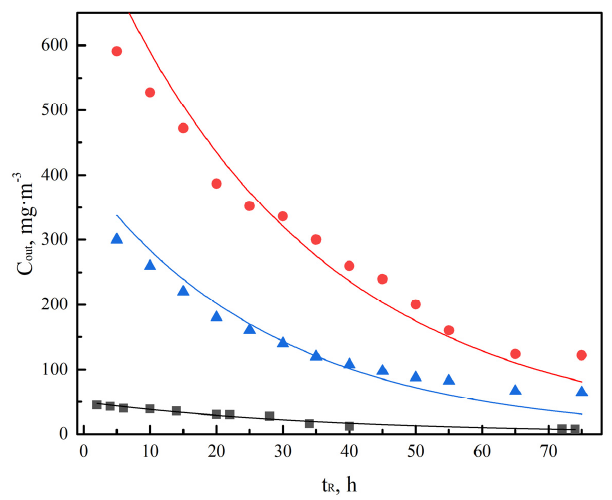
Figure 9. The relationship between outlet concentration of chlorobenzene and time of long-term run under different inlet concentrations of chlorobenzene. Liquid rate = 5.17 m 3 ·m − 2 ·h − 1 , pH = 6.5–7.0, oxygen concentration = 10%. ■ 100 mg·m − 3 ▲ 400 mg·m − 3 ● 800 mg·m − 3 .